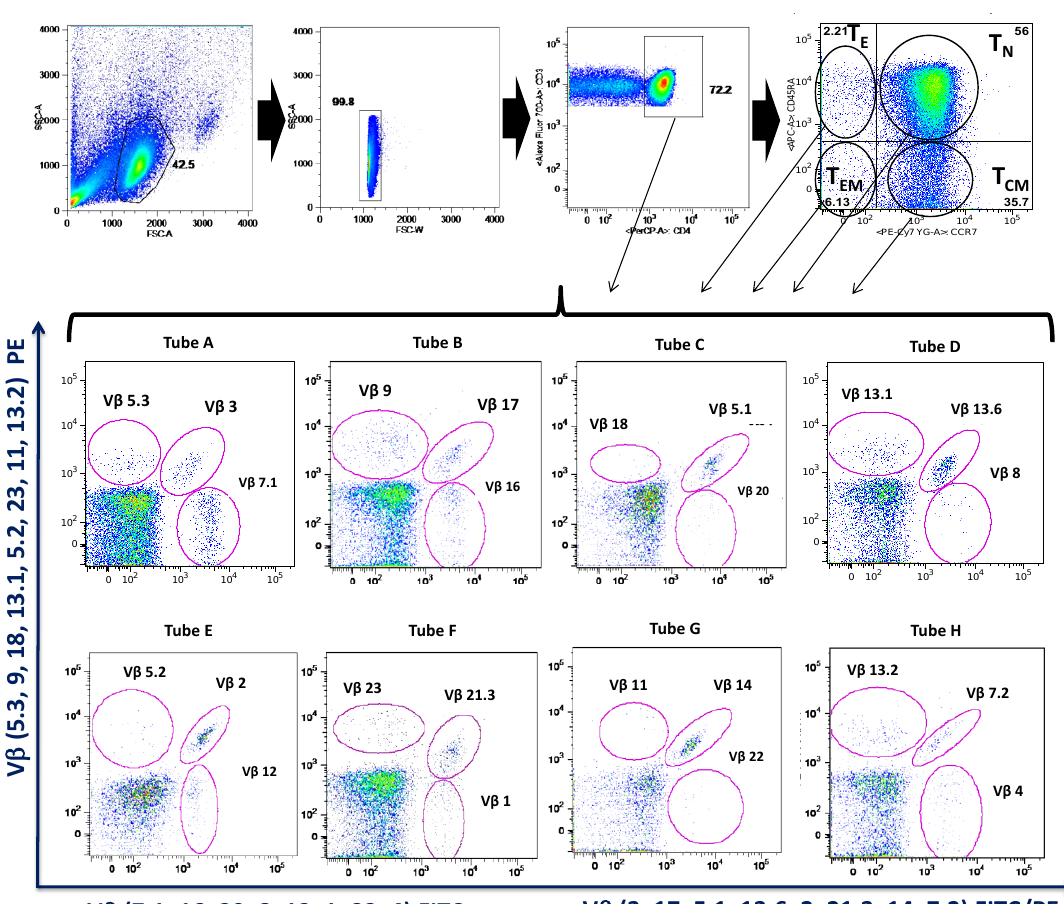
Figure 1. Study of the TCR V β s repertoire gating strategy on CD4 + T lymphocytes. Note. Dot plots represent the gating strategy and all TCR V β s repertoire evaluated in this study. Three V β are studied in FITC, PE or a combination of both fluorochromes in each activation/differentiation stages of CD4 + T lymphocytes.